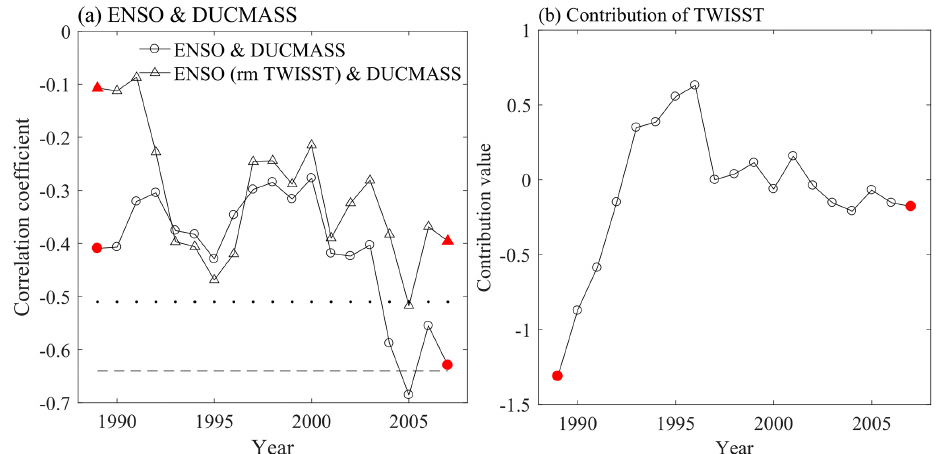
Figure 10. (a) The 15-year sliding correlation between DUCMASS and Niño-3 with and without TWISST-related signals removed. (b) Slid- ing contribution of TWISST to the DUCMASS–Niño-3 relationship. The two red-filled markers represented the 15-year window spanning from 1982 to 1996 and from 2000 to 2014, respectively. The x axis denotes the middle year of the period under analysis.